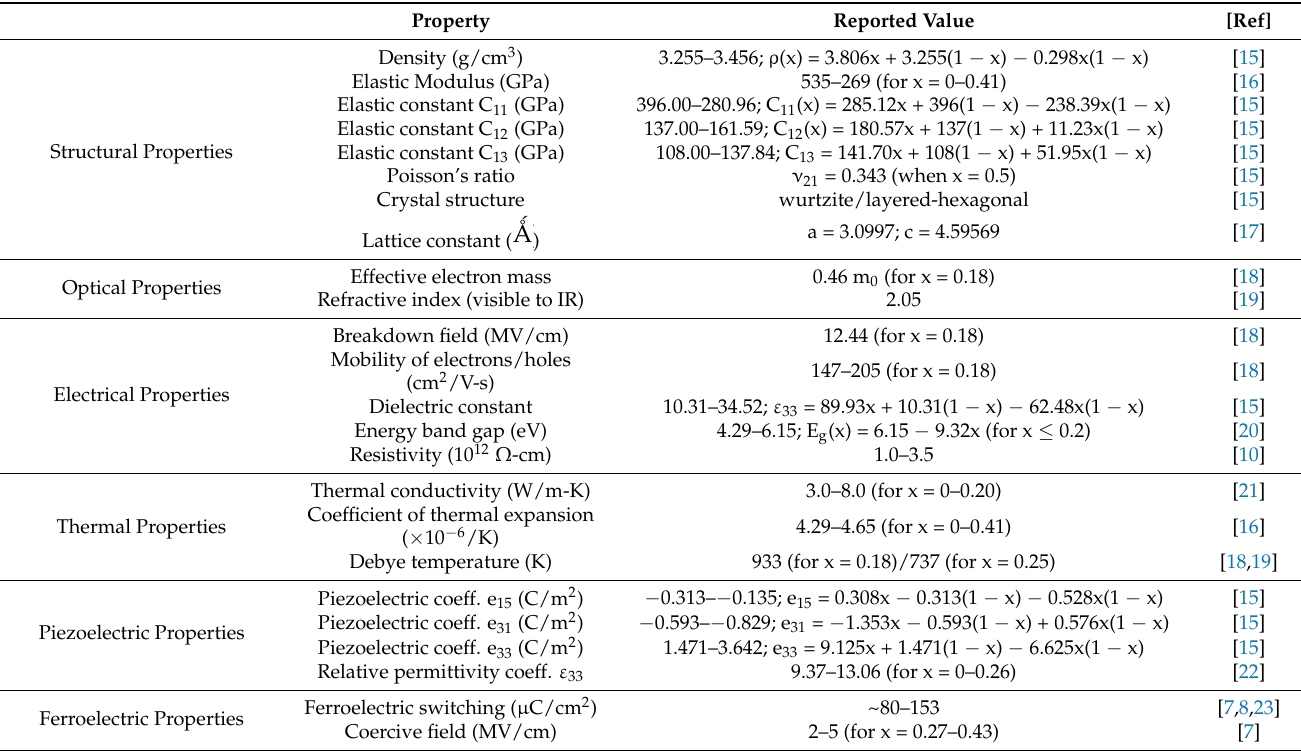
Table 1. Sc x Al 1 − x N properties.